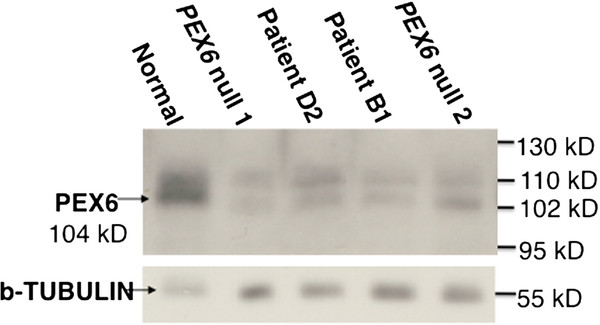
 PEX6 protein levels evaluated by immunoblotting. Results from cultured fibroblasts obtained from ZS patients B1 and D2 (both homozygous for PEX6  c.802_815del) are shown along with two PEX6 null mutants, and a normal control. Genotypes for PEX6 null mutant 1: c.[499_500del]; [2095-10_21del] and PEX6 null mutant 2: c.[1314_1320del];[2472-2A > G]. The results from b-tubulin analysis are provided as loading control